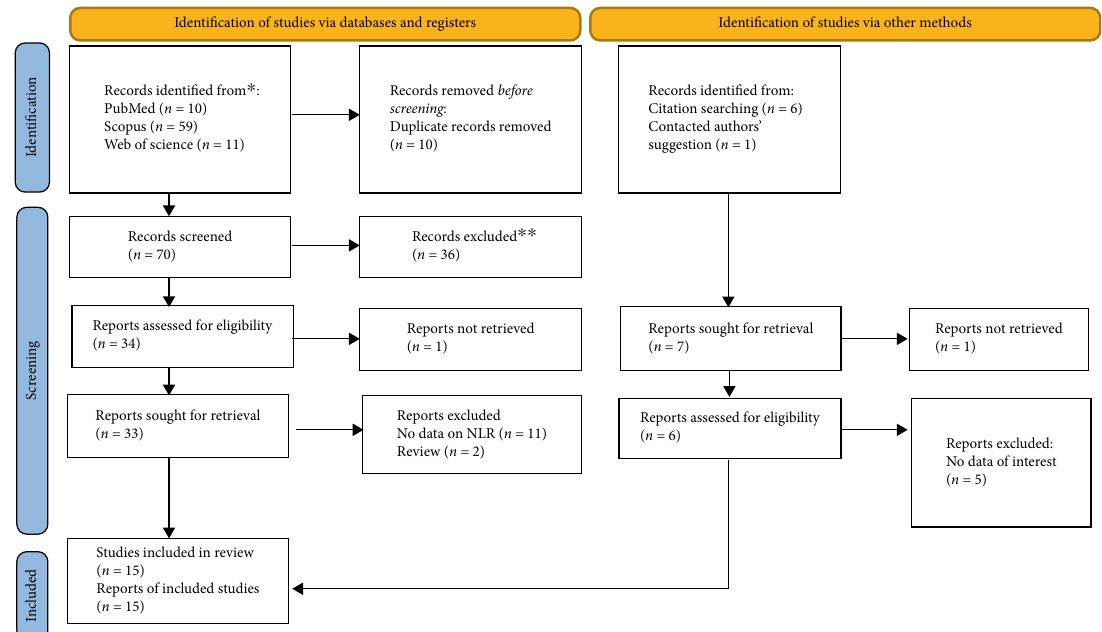
Figure 1: PRISMA 2020 fl ow diagram for new systematic reviews which includes searches of databases, registers, and other